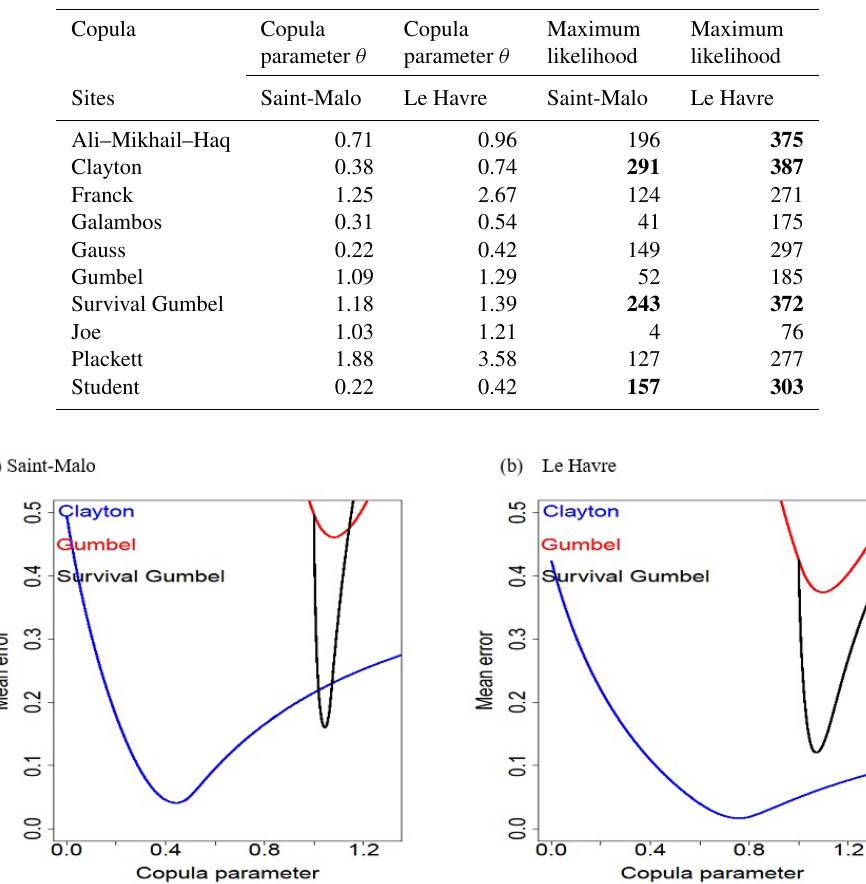
Figure 5. Evolution of the error according to the Clayton, Gumbel and survival Gumbel copula parameter in (a) Saint-Malo and (b) Le